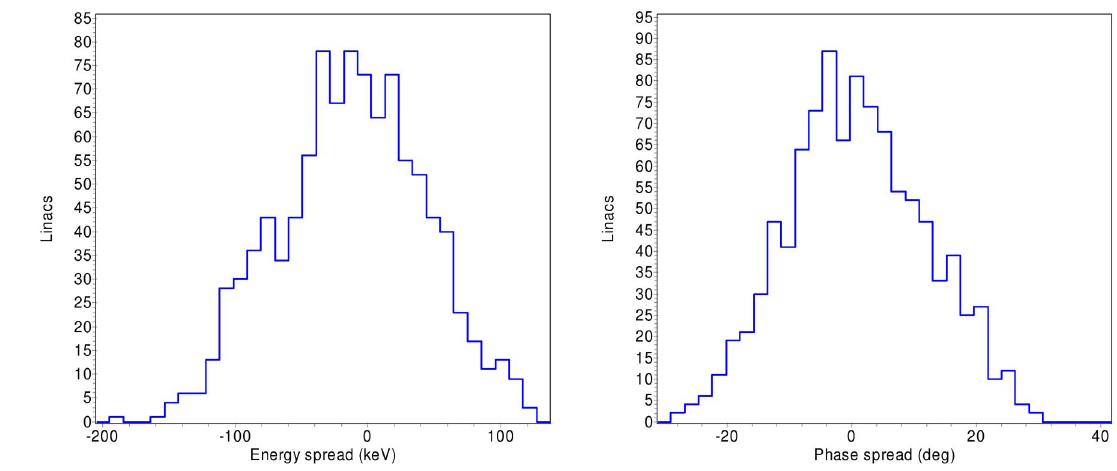
FIG. 17. (Color) Energy and phase distributions at linac exit (1000